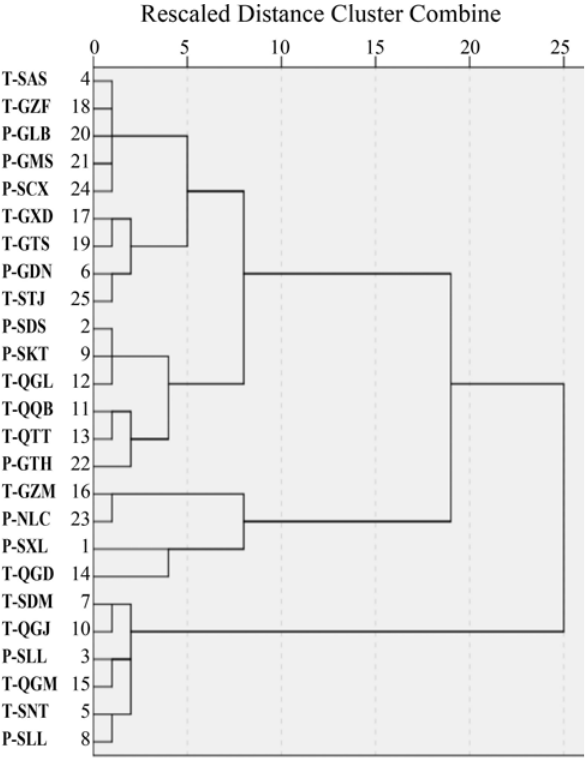
Fig 3. Cluster analysis of the contents of API in rhubarb from 25